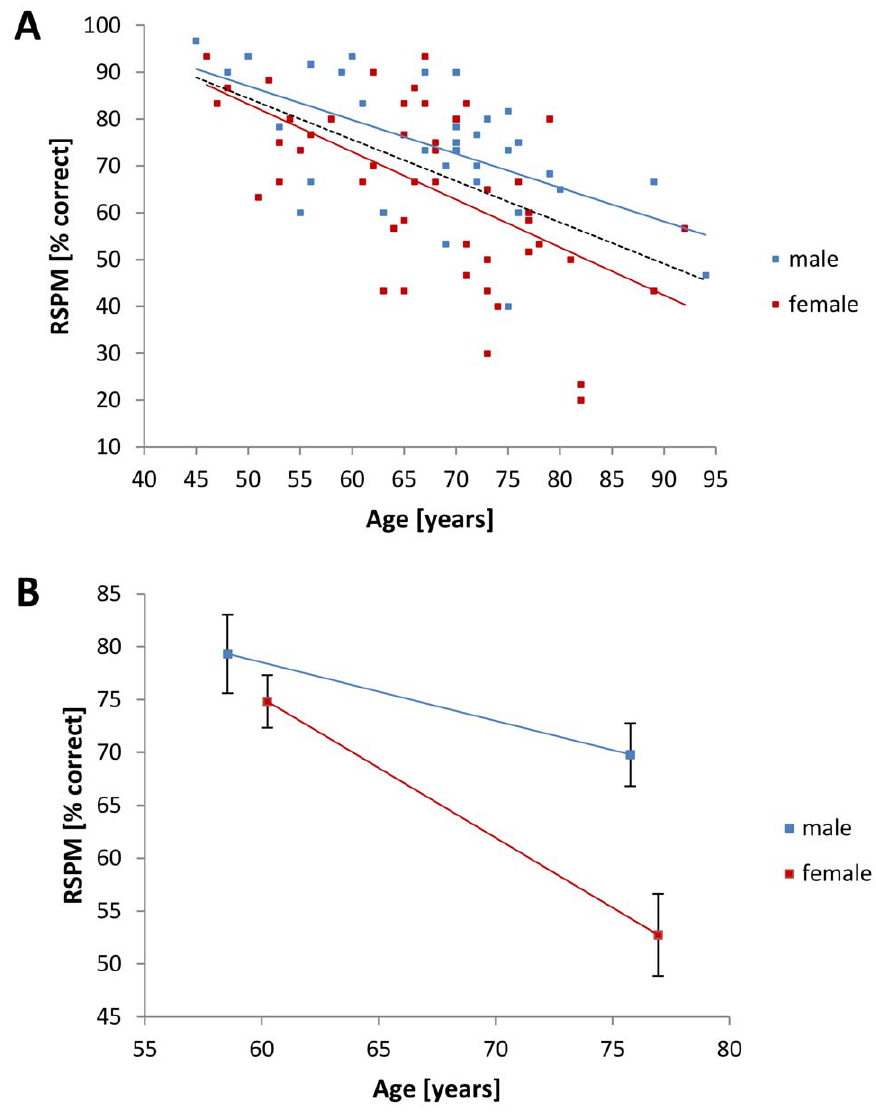
Figure 3. Development of cognitive performance in later life. A. Individual cognitive performance scores assessed with the RSPM test (i.e., percent correct answers) are depicted for male (blue squares, N=32) and female (red squares, N=49) subjects. Trend lines are shown for male (solid blue), female (solid red), and all subjects (dashed black). Cognitive performance declined with increasing age (Pearson correlation, N=81, r= 2 0.550, p # 0.001). B. Group data for cognitive performance (RSPM score, percentage correct) for younger adults (left squares; female: N=29, 60.24 6 7.07 years; male: N=15, 58.53 6 7.62years)andolder adults(rightsquares; female:N=20, 76.95 6 5.94years;male: N=17, 75.76 6 6.71years). Therewas nosignificant interaction of the subjects’ age and gender with their cognitive performance (AGE*GENDER: F (1,31) =17.535; p # 0.001). Black bars indicate